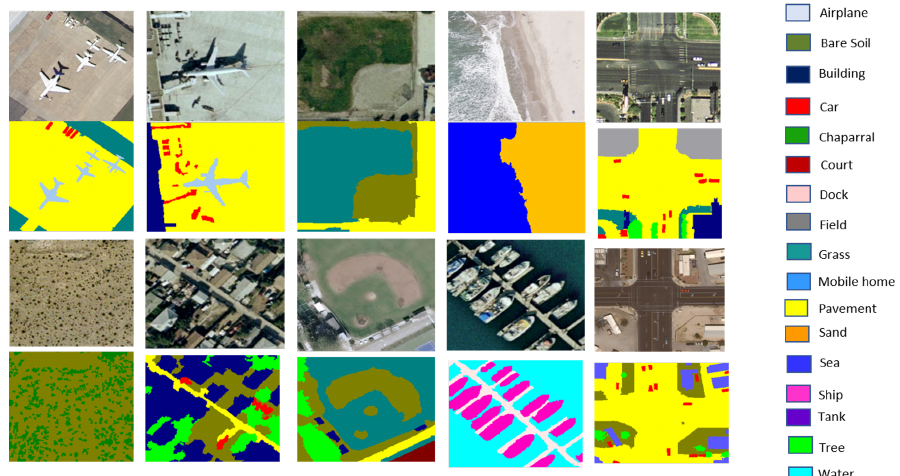
Figure 2. Sample images from the dataset and their corresponding ground truth segmented masks encoded in different colors. The first and third rows show the samples frames. Second and fourth rows show the corresponding segmentation